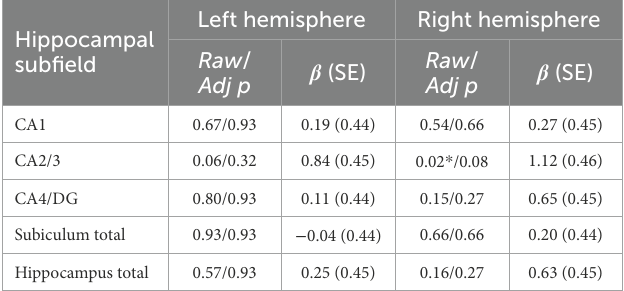
TABLE 2B Group effect in volumes between MDD patients and healthy controls, adjusting for age and sex using proportional odds ordinal logistic regression